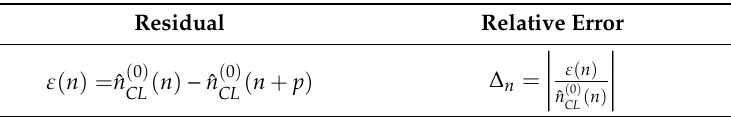
Table 5. Calculation of relative